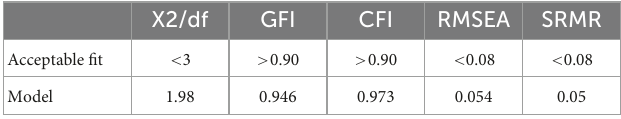
TABLE 2 Goodness of fit